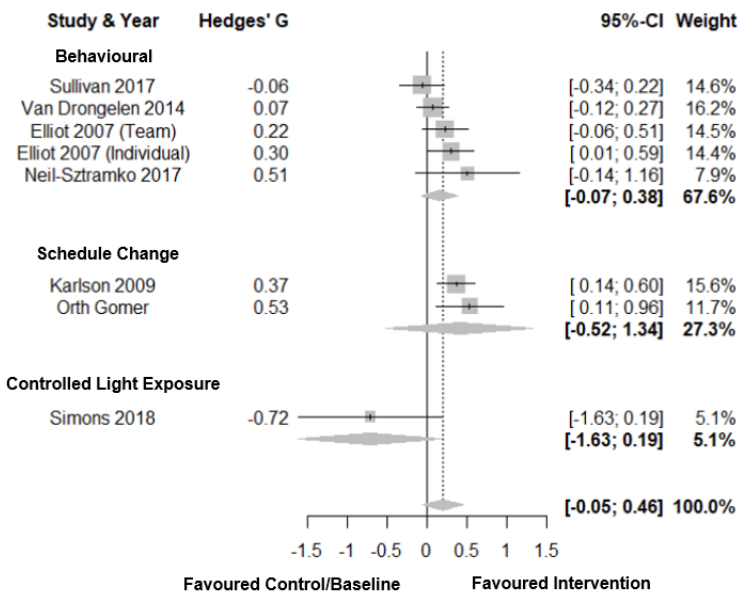
Figure 9. Forest plot for interventions by type on perceived health status. Note. Interventions with multiple conditions are denoted within brackets.